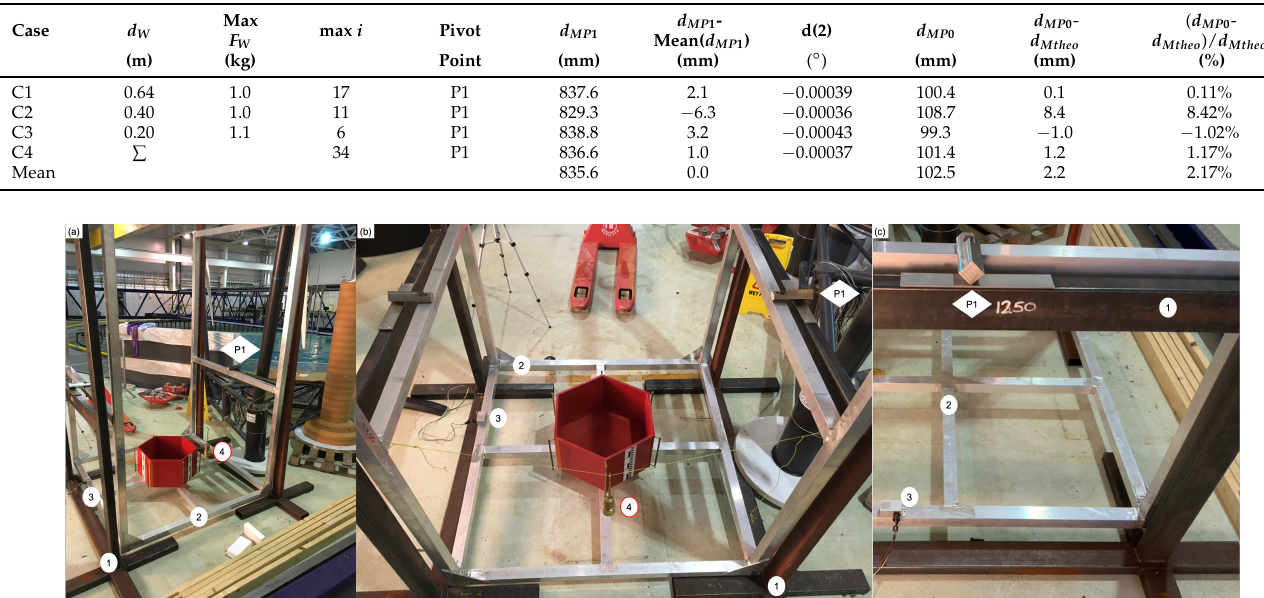
Table 4. Overview of the investigated cases for the example geometry presented in Figure 7—Data fitted based on Equation (2) similarly to the approach shown in Equation (11).